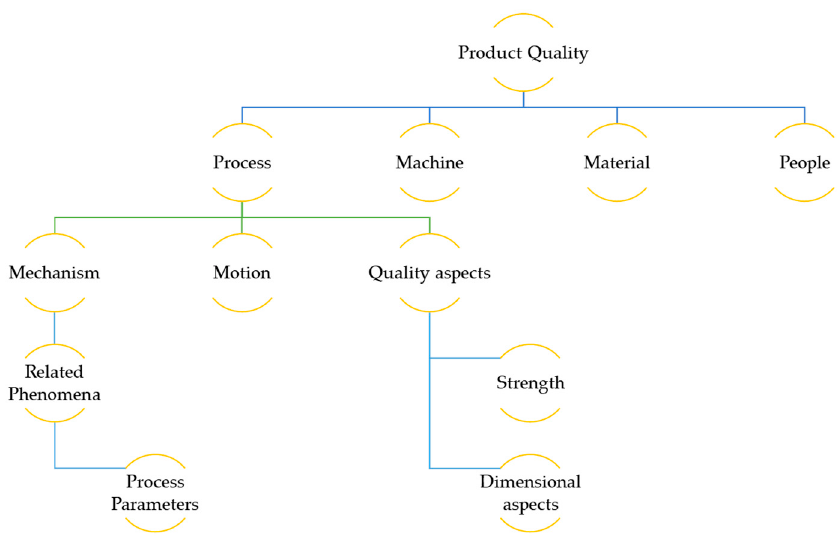
Figure 1. Issues in AM (adapted from